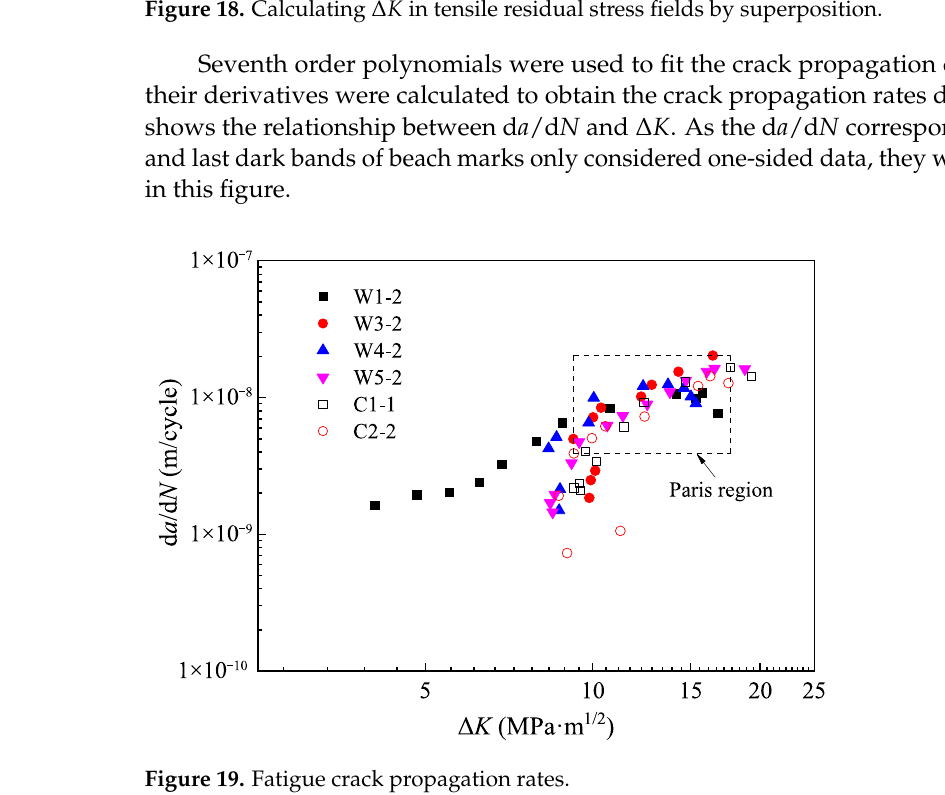
( , ) N a , and ( , ) N a , and i , and i i